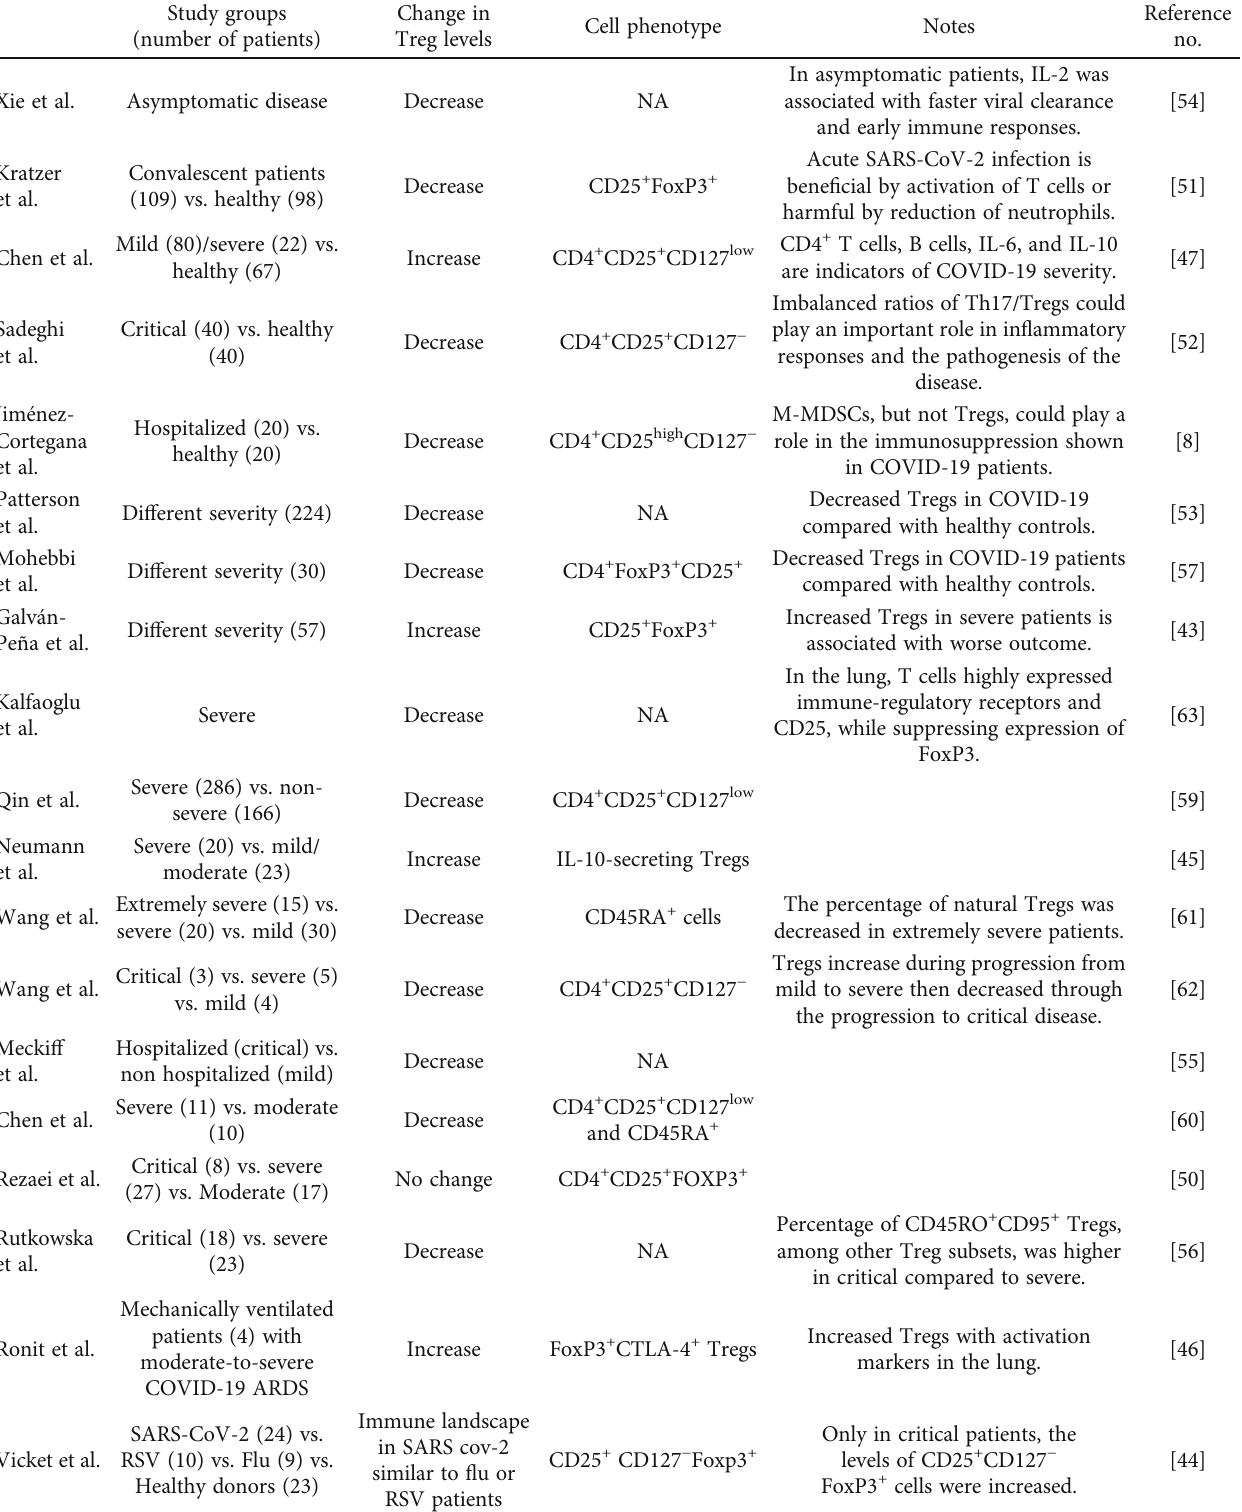
Table 1: Summary of Tregs in COVID-19 patients with di ff erent